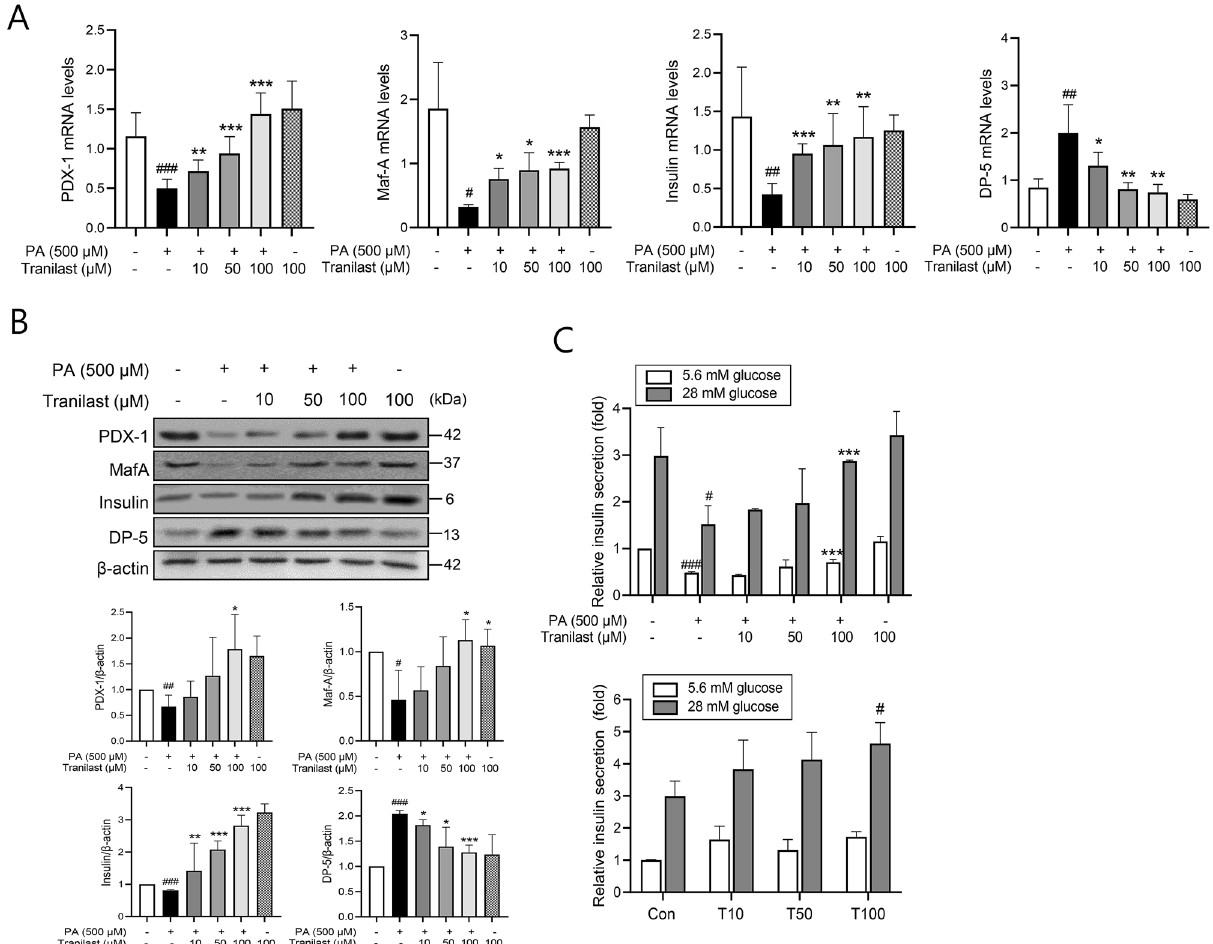
Figure 4. Tranilast restores PA-induced functional impairment. ( A,B ) INS-1 cells were treated with PA (500 μM) in the presence or absence of tranilast at the indicated concentrations for 8 h (real-time qPCR) or 24 h (western blotting). Expression of PDX-1, MafA, insulin, and DP-5 was determined by real-time qPCR (A) , and by western blot analysis (B) . Original scans of whole blots are shown in Supplementary information. Density analyses of western blots were shown in the lower panel. Data are expressed as mean ± SD of three independent experiments, each done in duplicate. # p < 0.05, ## p < 0.01, ### p < 0.005 versus control, * p < 0.05, ** p < 0.01, *** p < 0.005 versus PA alone. (C upper ) INS-1 cells were treated with PA (500 μM) in the presence or absence of tranilast at the indicated concentrations for 24 h, and further incubated in the same buffer containing 5.6 or 28 mM glucose for 30 min. Insulin level in the media was quantified using an insulin RIA kit. (C lower ) Primary islets isolated from C57BL/6J mice were treated with various concentrations of tranilast for 24 h, and the insulin content in the media was measured using mouse insulin RIA kit. Data are expressed as mean ± SD of three independent experiments, each done in duplicate. # p < 0.05, ### p < 0.005 versus control, *** p < 0.005 versus PA